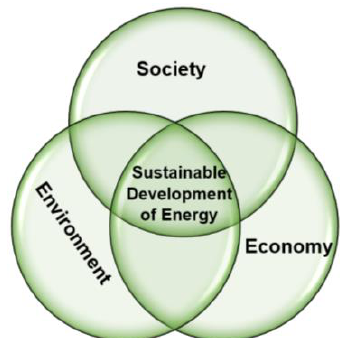
Figure 2. The relationship between the sustainable development of energy and the environment, society and